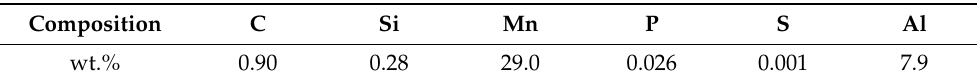
Table 1. Appearance and dimensions of the as-rolled lightweight steel; the locations of the microstruc- tural samples were